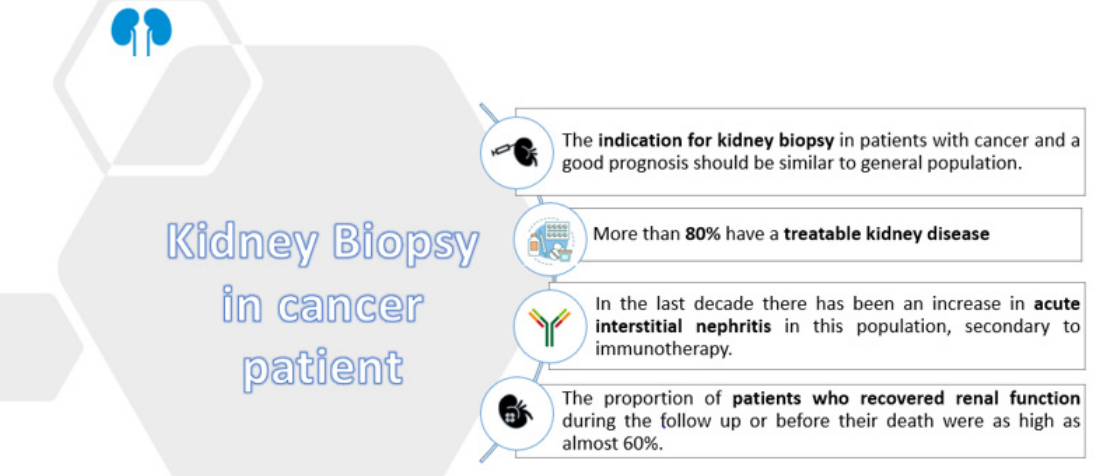
Figure 4. Kidney biopsy in cancer patients. Proposed beneficial results of performing a kidney biopsy in cancer patients with kidney